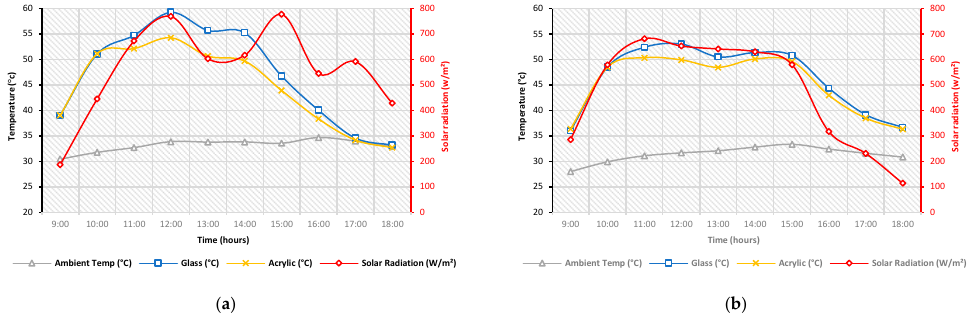
Figure 13. Variation in solar intensity and inner cover temperature: ( a ) 21 February 2020 and ( b ) 1 August 2020.